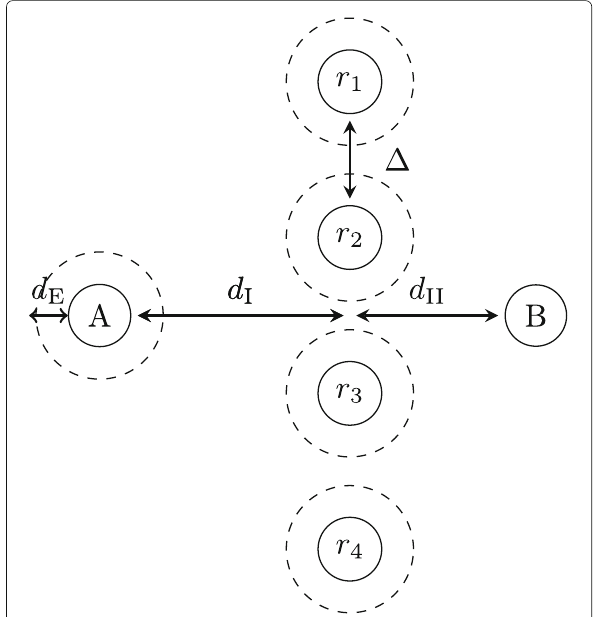
Fig. 7 Node position diagram. (A) Alice, (B) Bob, r n : relay